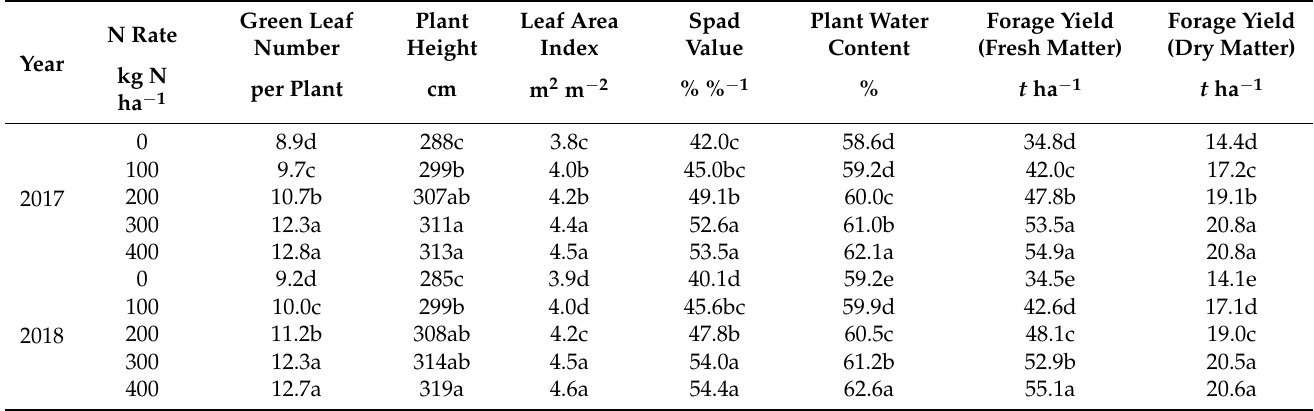
Table 1. Maize green leaf number, plant height, ear height, stem diameter, leaf area index, Spad value, plant water content and forage yield in 2017 and 2018.